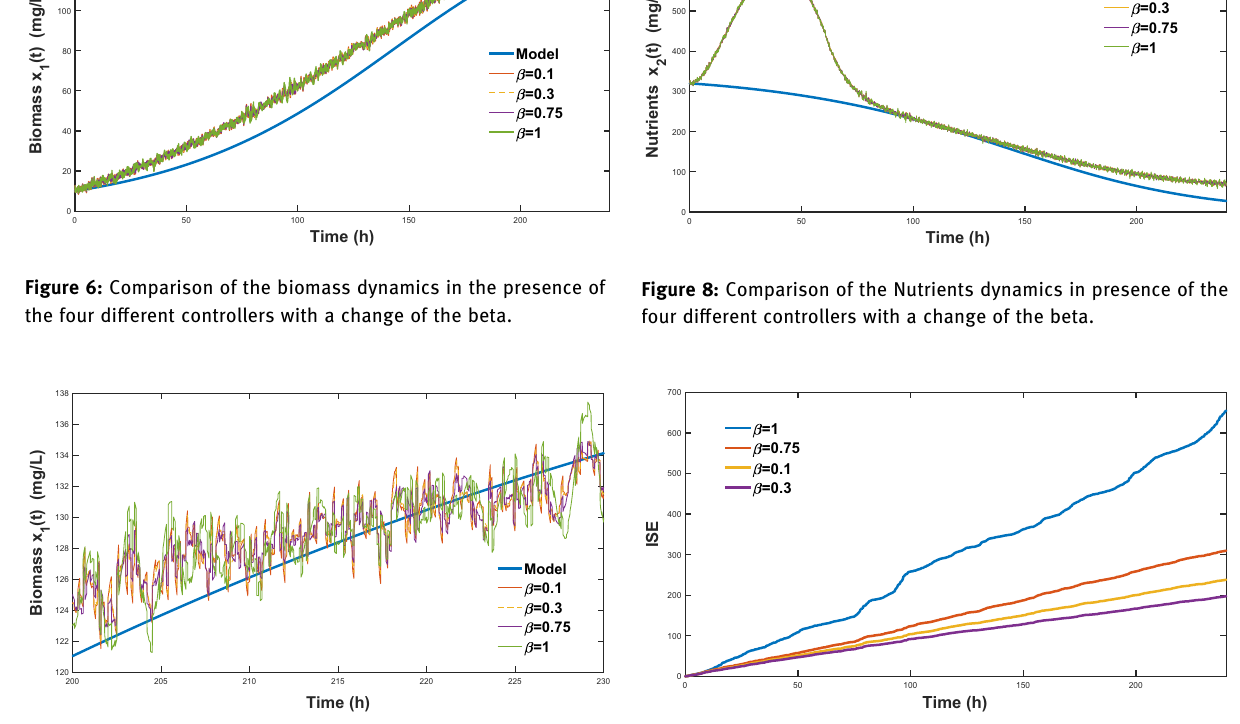
Figure 9: Comparison ISE error criteria of the four di ff erent con - trollers with a change in the β